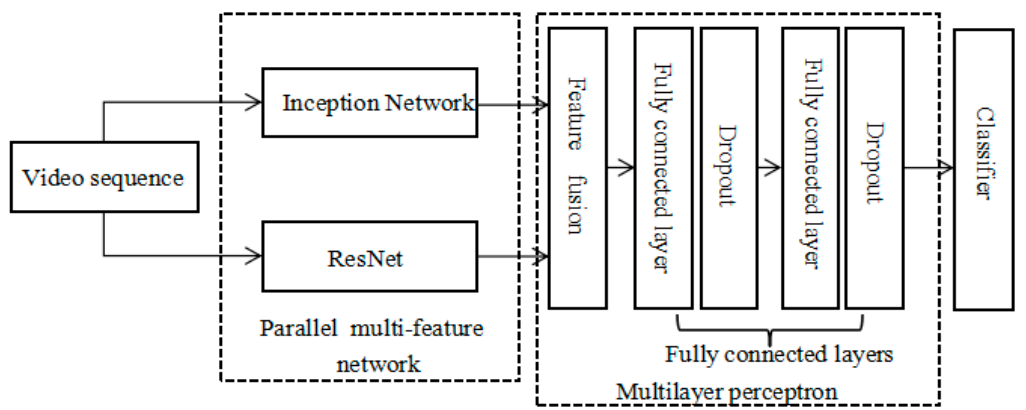
Figure 4. Block diagram of the parallel multi-feature fusion network algorithm.